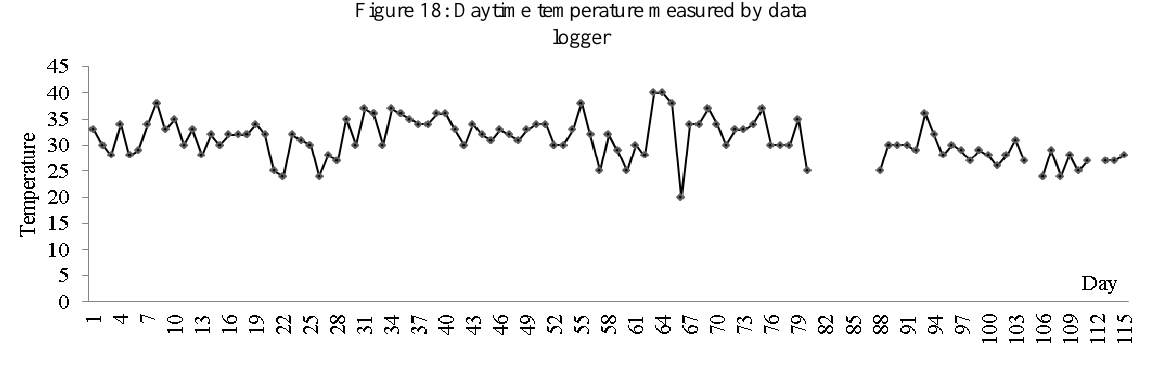
Figure 19: Nighttime temperature measured by data